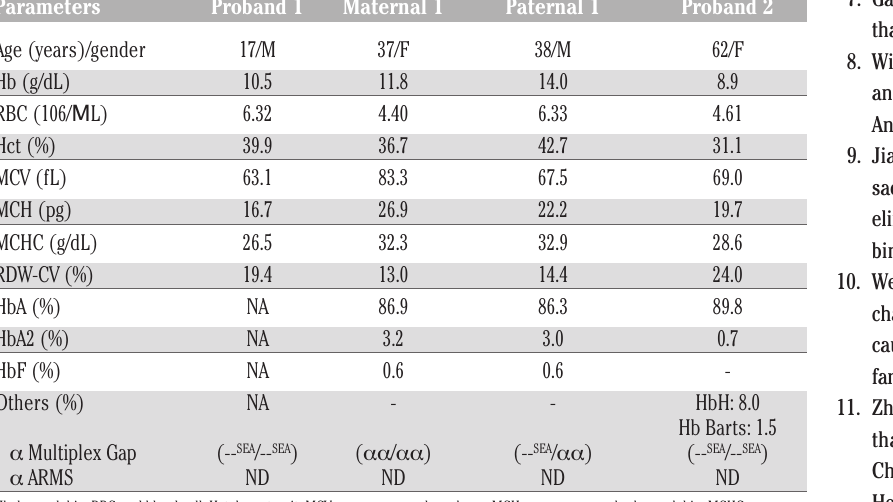
Table 1. Hematological indices and primary molecular findings for all four patients.